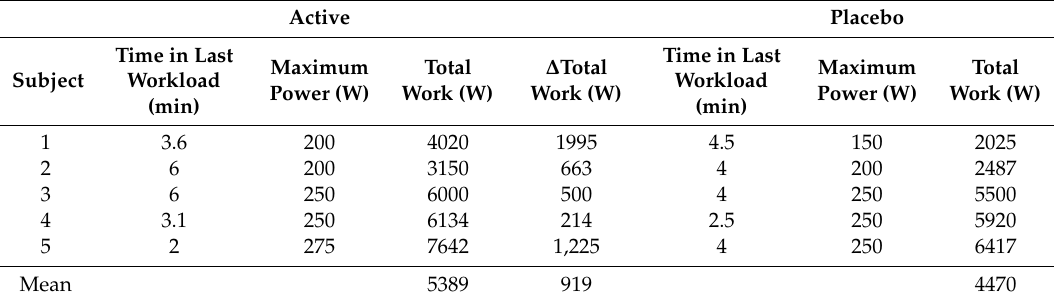
Table 6. Maximal test performance.